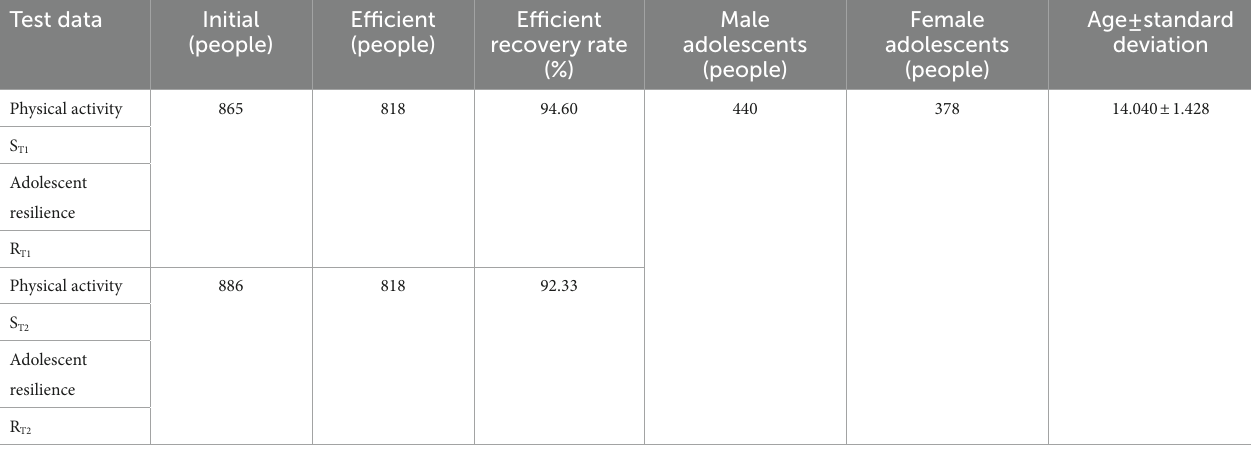
TABLE 1 Descriptive statistics for physical activity and adolescent resilience.